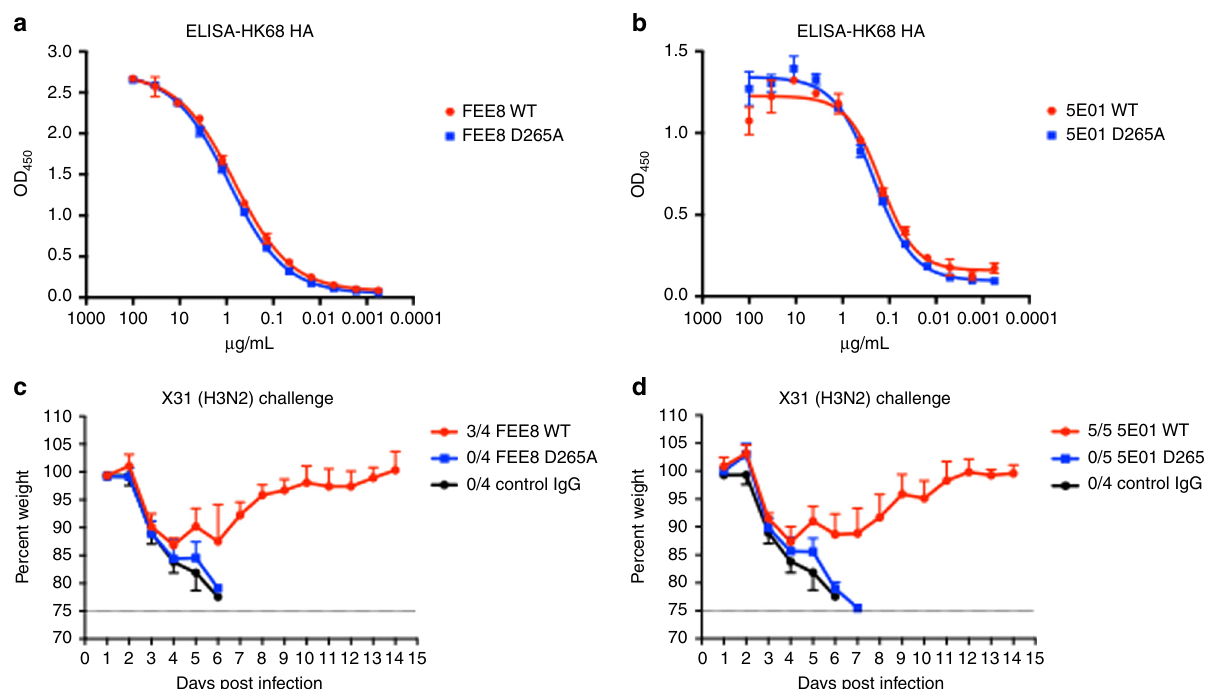
Fig. 7 In vivo protection by nonNAbs is dependent on Fc-receptor engagement. The variable regions of FEE8 and 5E01 were cloned into murine IgG2a WT or murine IgG2a D265A backbone, respectively. ELISA assays were performed using recombinant HK/68 H3 HA to assess the binding af fi nities of ( a ) FEE8 WT and FEE8 D265A, or ( b ) 5E01 WT and 5E01 D265A. c , d BALB/c mice were administered IP with 6 mg per kg of each antibody and then challenged IN with 5 mLD 50 of X31. A mAb against GST was used as an IgG control. The ratios in the fi gure legends indicate the number of animals that survived challenge over total number of animals per group ( n = 4 or 5). Values represent mean ±